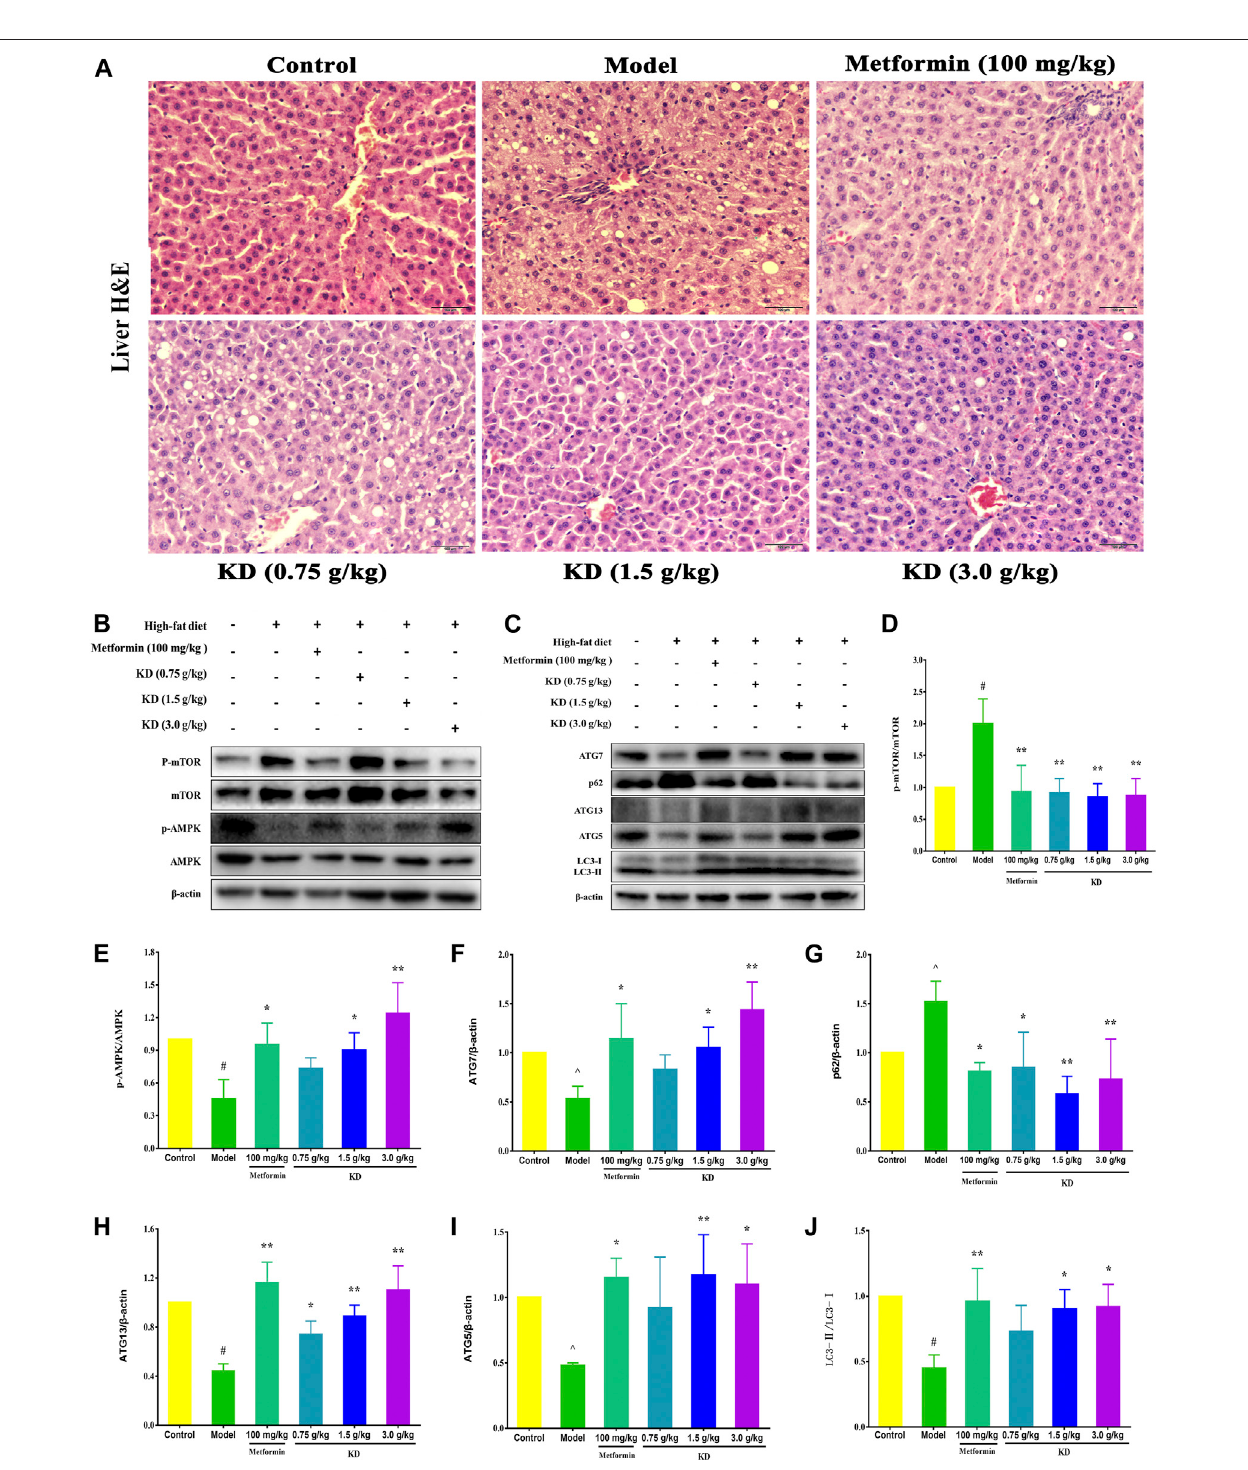
FIGURE 10 | KD activates autophagy to prevent hepatic steatosis in high-fat diet-fed rats. SD rats were fed a normal chow diet or a high-fat diet for 6 weeks, then administratedwithmetformin(100 mg/kg)orKD(0.75 g/kg,1.5 g/kgand3.0 g/kg),andsacri fi ced6 weekslater. (A) LiversectionswerestainedwithH&E,whichshows tissue composition, lipid droplets, and hepatocyte swelling in the livers of high-fat diet-fed rats. (B – J) Western blot analysis for mTOR, p-mTOR (Ser2448) (D) , AMPK, p-AMPK (Thr172) (E) , Atg7 (F) , p62 (G) , Atg13 (H) , Atg5 (I) and LC3- Ⅱ / Ⅰ (J) . Data were presented as mean ± SD ( n (cid:2) 3 in each group).